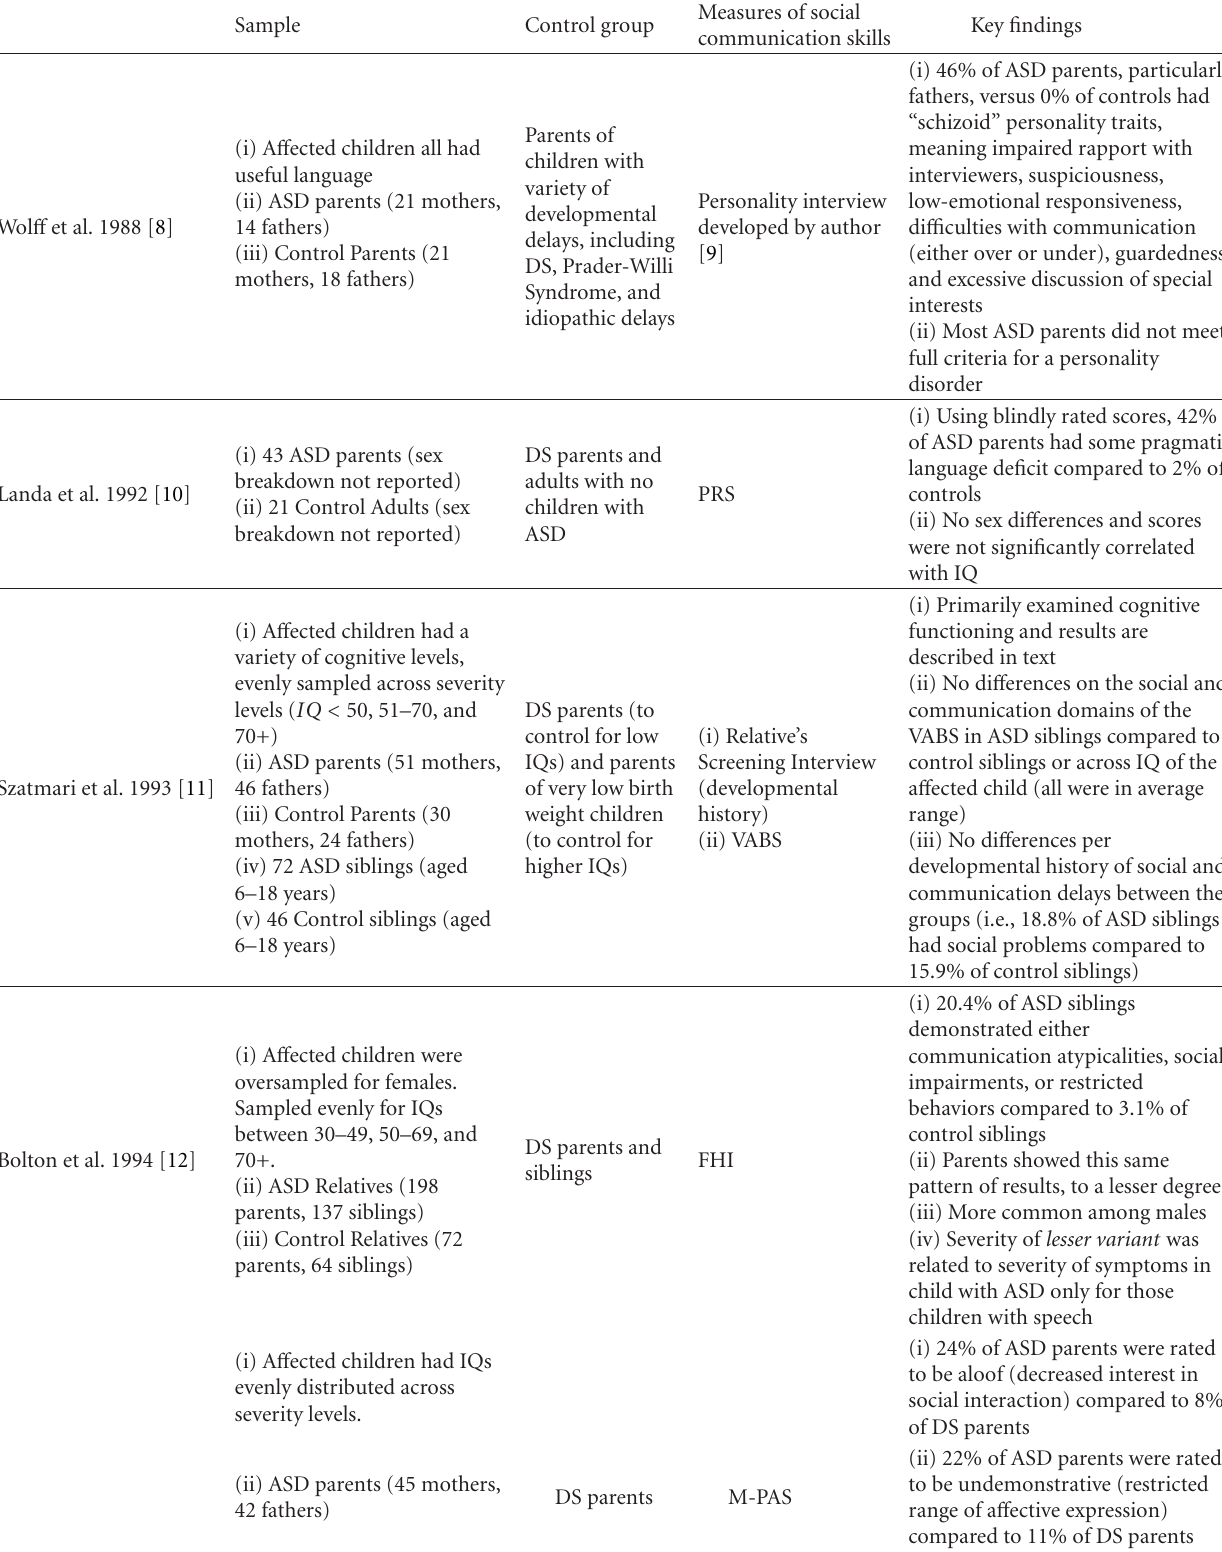
Table 1: Investigations of social abilities, communication skills, and personality traits in ASD parents and